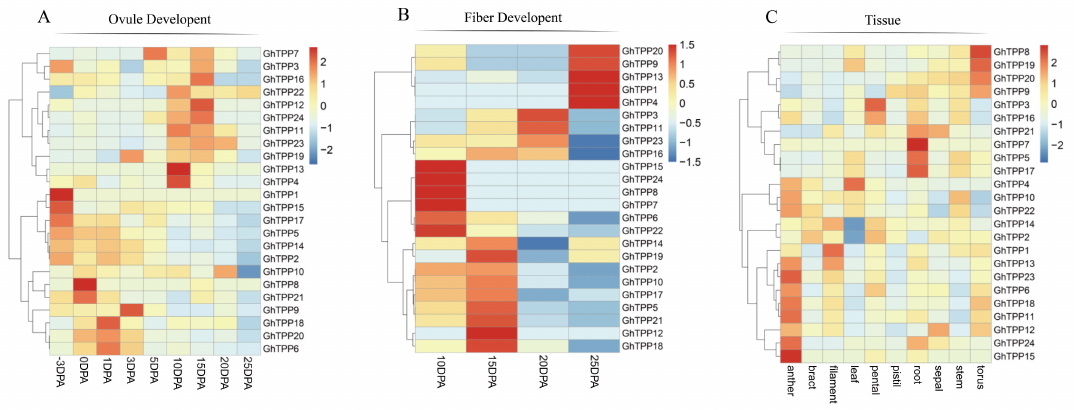
Figure 8. TPP gene expression profiles during different developmental periods and in different tissues of G. hirsutum . The transcriptomic data were normalized via log2 (FPKM+1) to generate a heatmap. ( A ) Expression of TPP genes in G. hirsutum at different stages of ovule development. ( B ) Expression of TPP genes at different stages of G. hirsutum fibre development. ( C ) Expression of TPP genes in different